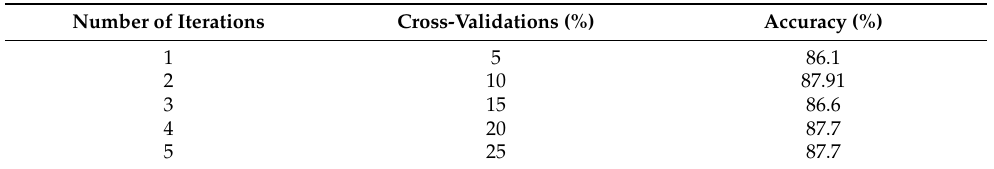
Table 6. Results for J48 decision tree classifier.